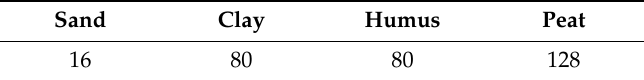
Table 2. Buffer capacities of various soil types (mmol H + kg − 1 pH − 1 ). Sand Clay Humus Peat 16 80 80 128